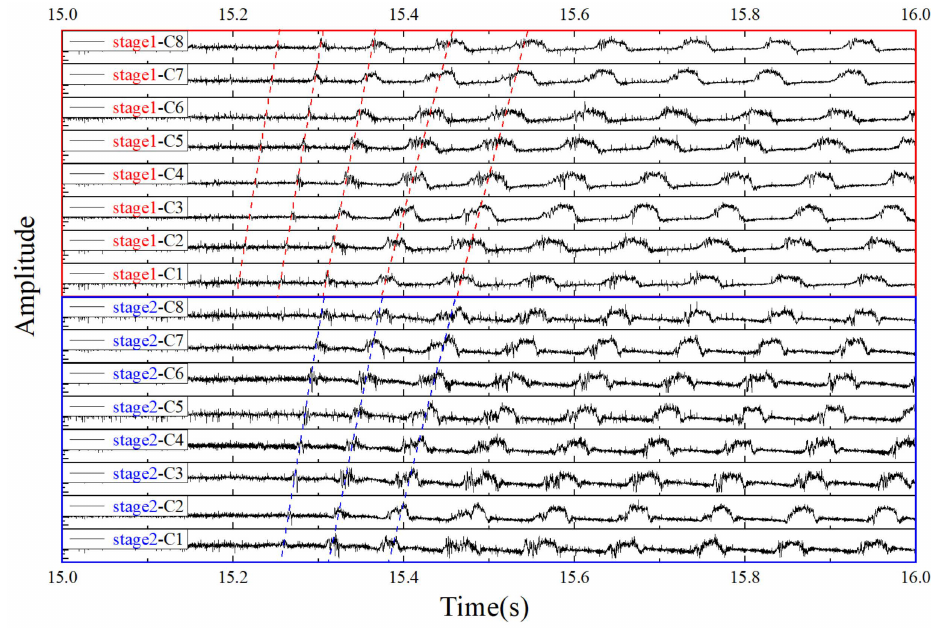
Figure 12. Dynamic static pressure signals in the evolution of rotating